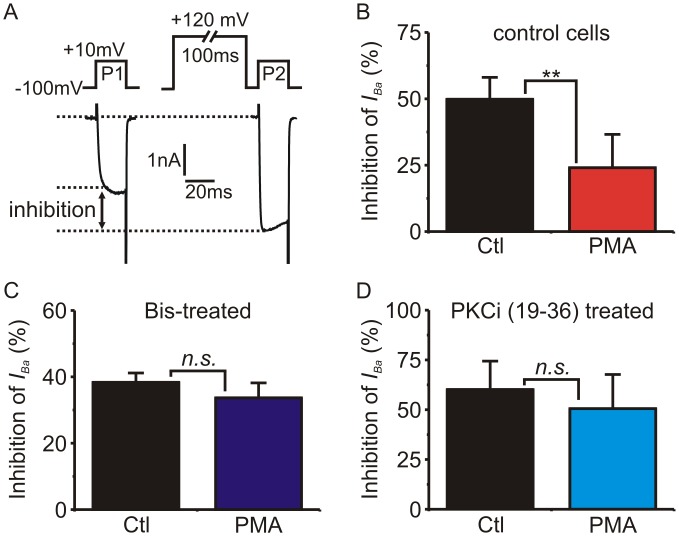
Bisindolylmaleimide-1 and PKC(19–36) effectively block the effects of PKC / phorbol ester on Gβγ-mediated inhibition of I
Ba.G1A1 cells (that stably express CaV2.2, β1b and α2δ) were transiently transfected with G-protein β1 and γ2 subunits (Gβγ). (A) Representative traces showing use of a depolarizing prepulse protocol to quantify the tonic inhibition of I
Ba produced by Gβγ. (B) The magnitude of Gβγ-mediated inhibition was determined using the prepulse protocol (panel A) first in the absence and then in the presence of PMA (200 nM). PMA significantly diminished the Gβγ-mediated inhibition (p = 0.0015, n = 5, paired t-test). (C) Preincubation of cells with bisindolylmaleimide-1 (Bis; 500 nM) blocked the ability of PMA to reduce Gβγ-mediated inhibition (p = 0.75, n = 5, paired t-test). (C) PKC(19–36) in the patch pipette solution blocked the ability of PMA to reduce Gβγ-mediated inhibition (p = 0.09, n = 3, paired t-test).